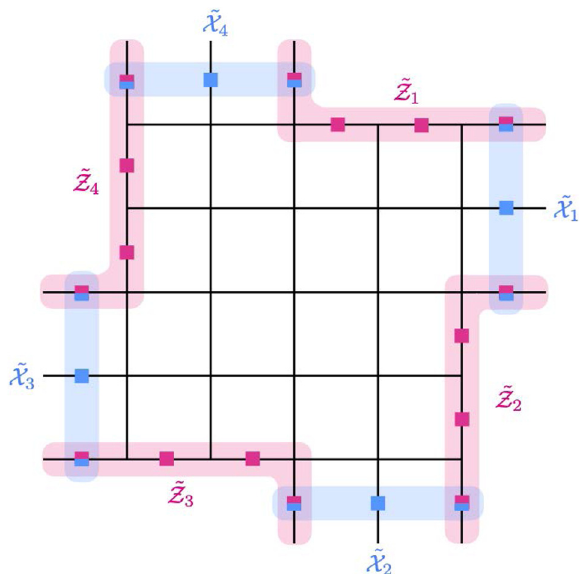
FIG. 9. A surface-code lattice encoding multiple qubits. An example of a square lattice with alternating rough and smooth boundaries is shown. As in the main text, qubits live on the links of the lattice. There are four rough boundary segments and four smooth boundary segments, corresponding to N = 4. Operators ˜ X ˜ Z i and i analogous to Eqs. (7) are indicated by the magenta- and blue-shaded regions, respectively. Each consists of the product of Z or X operators within the shaded region,